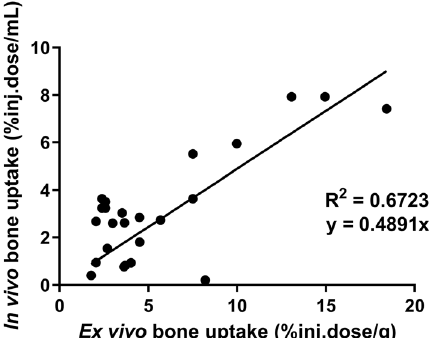
Fig. 4 Correlation between in vivo (% inj.dose/mL) and ex vivo (% inj. dose/g) measurements of [ 18 F]fluoride uptake into bone, measured at Values are the means (SD); n 6 for parietal bone and n 3–5 for other bones 60 min after tracer = = % inj.dose/g percent of the injected dose per gram of tissue, CJ costochondral joint injection. Low tracer uptake was observed in the myo- cardium, therefore, the blood input function for kinetic As shown in Figs. 1 and 2b (in vivo) and in Additional modeling of the in vivo scanned data was measured in file 1: Fig. S3a (ex vivo), [ 18 F]fluoride was rapidly cleared the left cardiac ventricle. Park-Holohan et al. suggested from the blood during the first few minutes after the